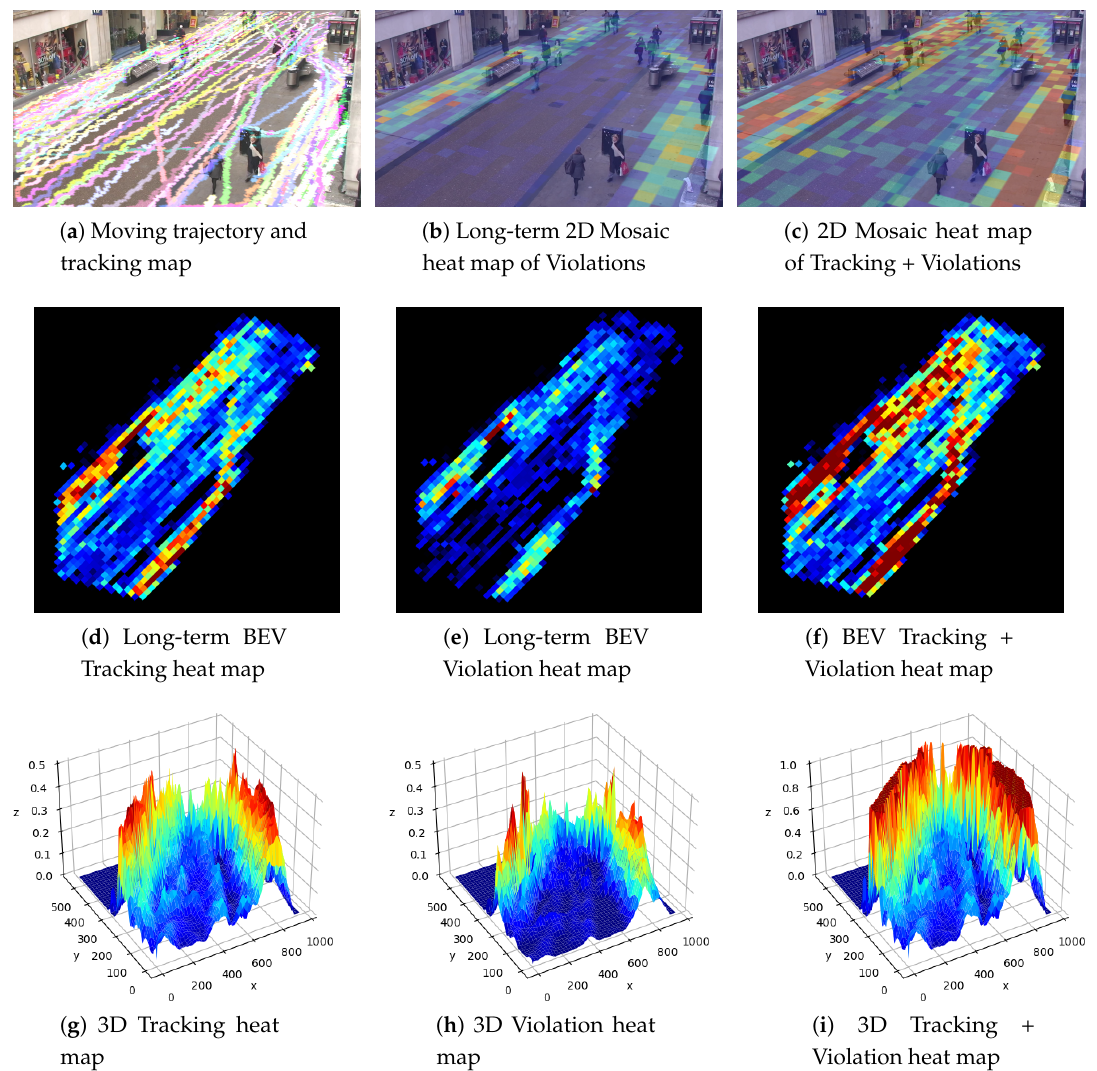
Figure 17. Data analysis based on people detections, tracking, movements, and breaches of social distancing